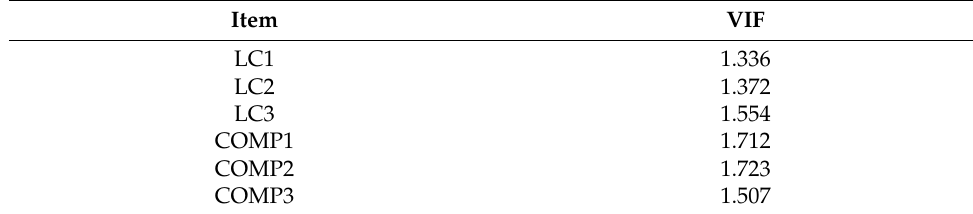
Table 11. Collinearity assessment.